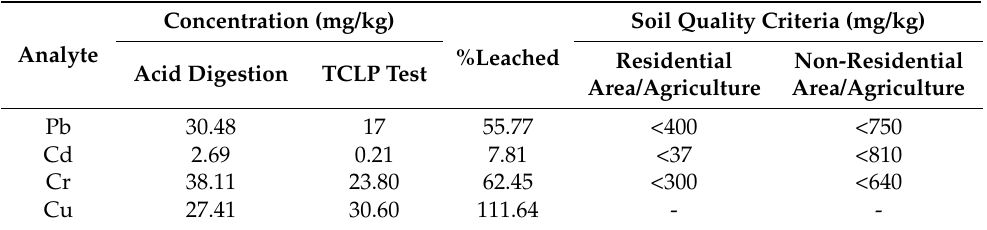
Table 4. Concentrations of heavy metal elements leached out from cenospheres by TCLP